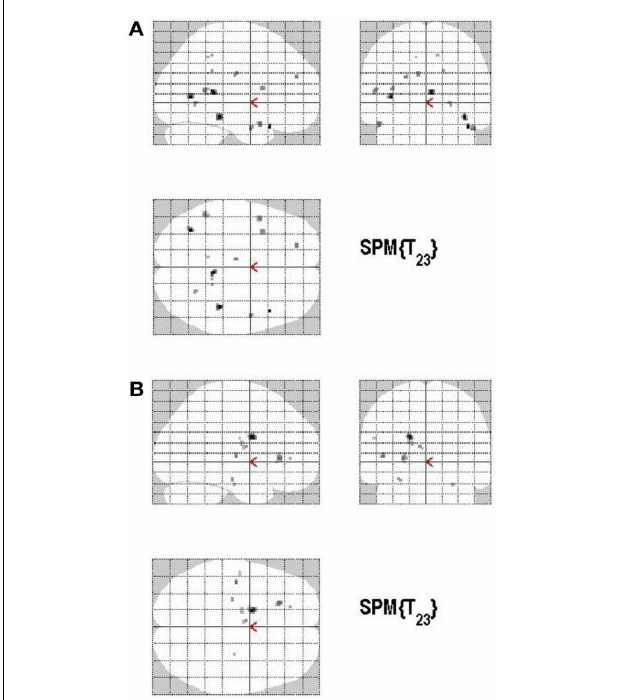
FIGURE 6 | (A) Group activations for the contrast between volunteering versus withholding (CONTROL). Activations are superimposed on the anatomical group mean image (see Materials and Methods), depicting statistically significant relative increases in neural activity at p < 0.001, uncorrected. See Table 3A for the exact MNI coordinates. (B) Group activations for the contrast between withholding versus volunteering (CONTROL). Activations are superimposed on the anatomical group mean image (see Materials and Methods), depicting statistically significant relative increases in neural activity at p < 0.001, uncorrected. See Table 3B for the exact MNI coordinates.